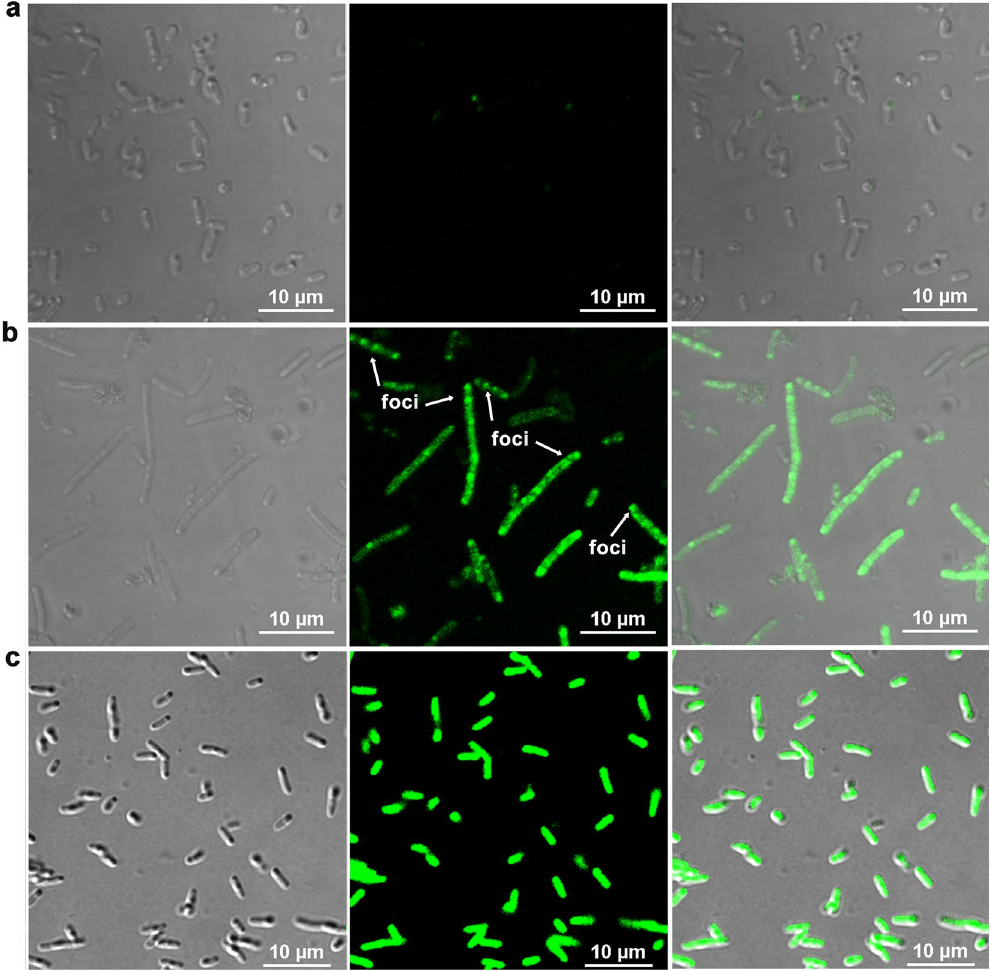
Figure 7. CarD forms amyloid inclusions in vivo . The confocal fluorescence microscopic images of bacterial cells over-expressing ( a ) empty vector, ( b ) CarD, and ( c ) CarDtr. The left, middle and right panels correspond to the phase contrast microscopy, fluorescence microscopy and merged images captured under UV light. Scale bar corresponds to 10 μ